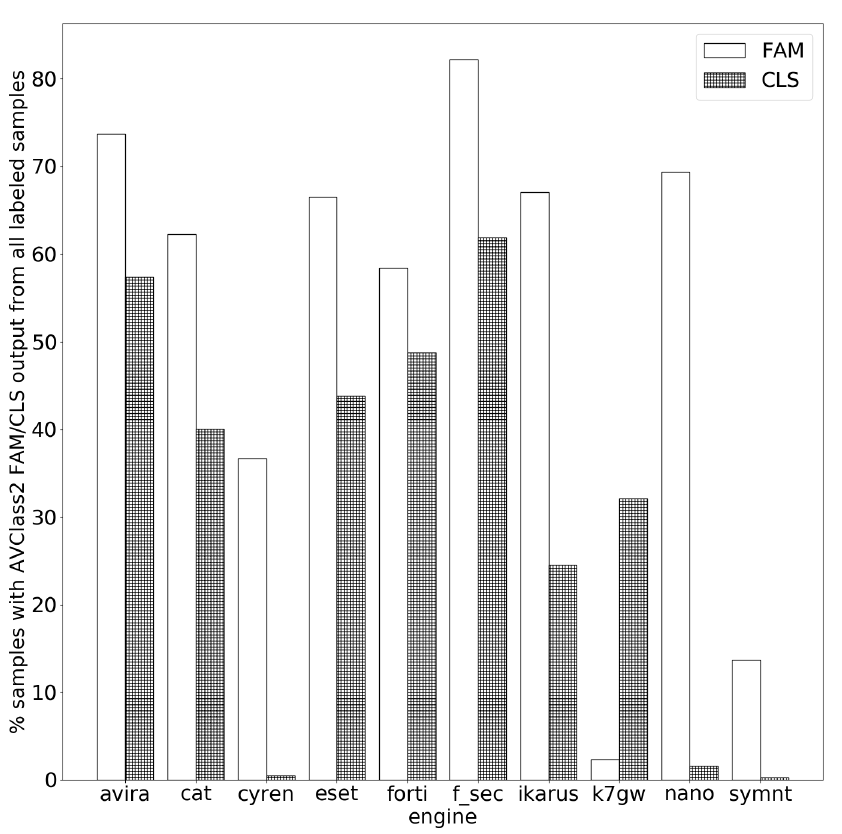
Figure 3. Percentage of family/class detections in all labeled samples for the top 10 engines in coverage.